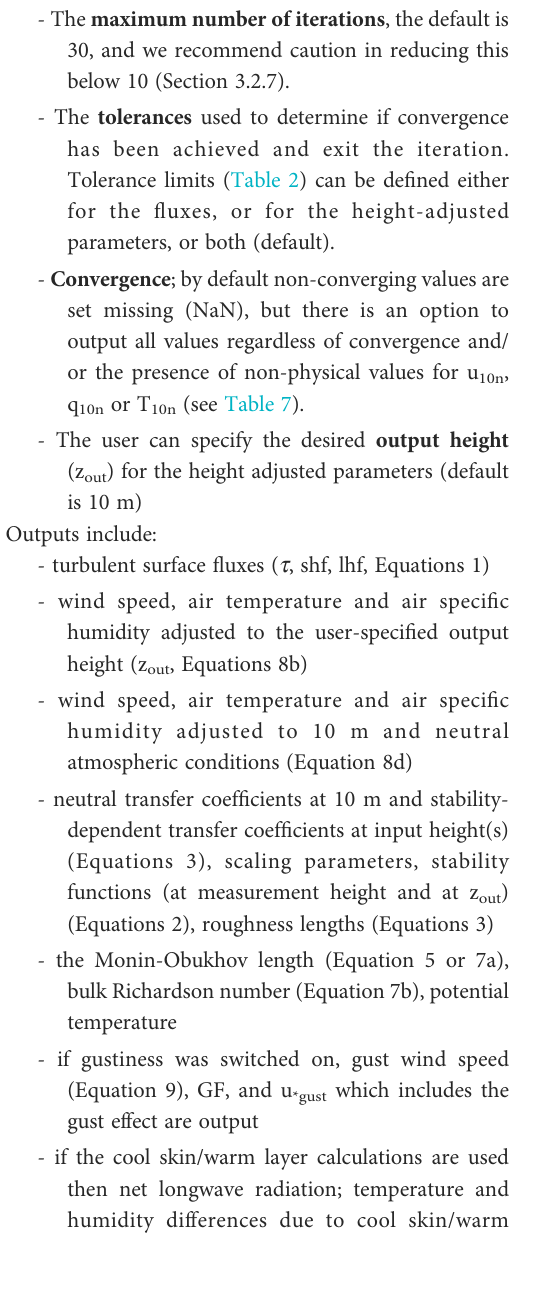
TABLE 8 De fi nition of the terms used to describe changes to TSF and